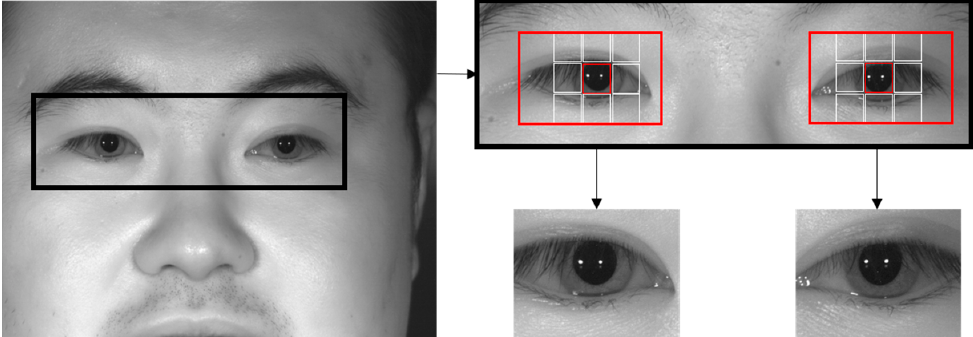
Figure 3. Example of rough detection of ocular ROI in CASIA-Iris-Distance database.